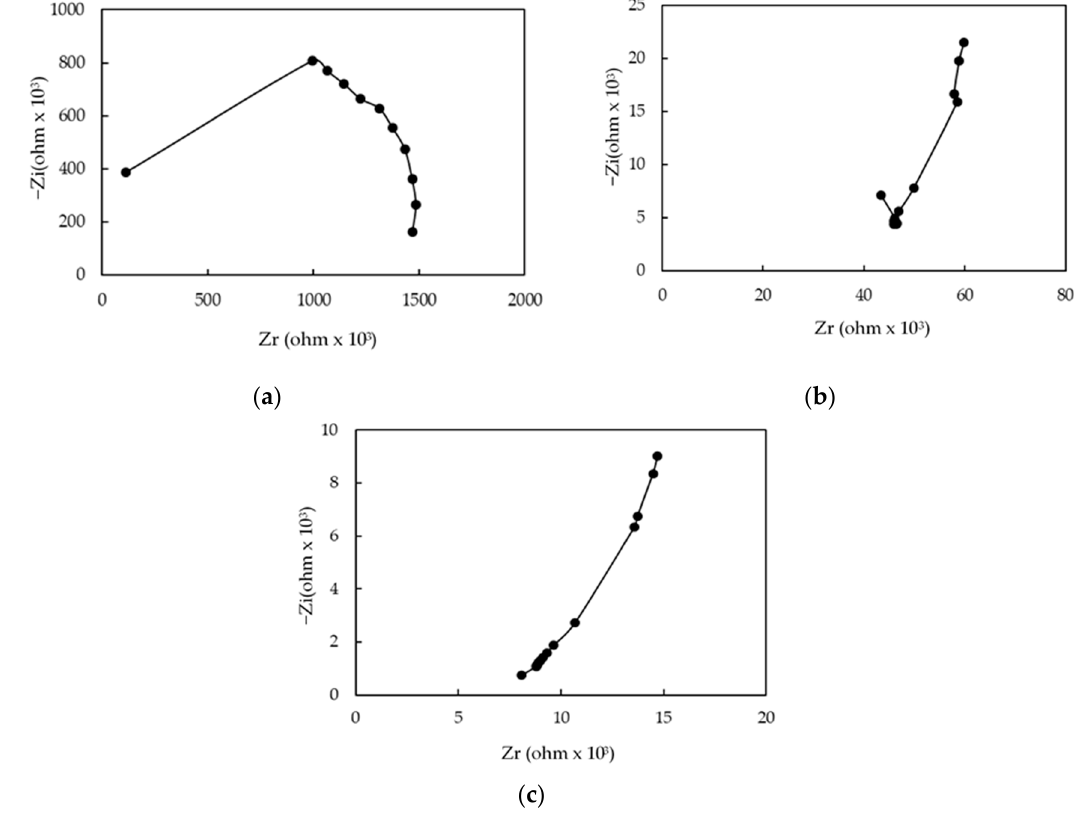
Figure 8. Complex impedance plots of humidity sensor that was made of Ag MWs (6 mg)/PPy (0.1 g)/SnO 2 ternary composite film at ( a ) 20% RH, ( b ) 40% RH, and ( c ) 80% RH.